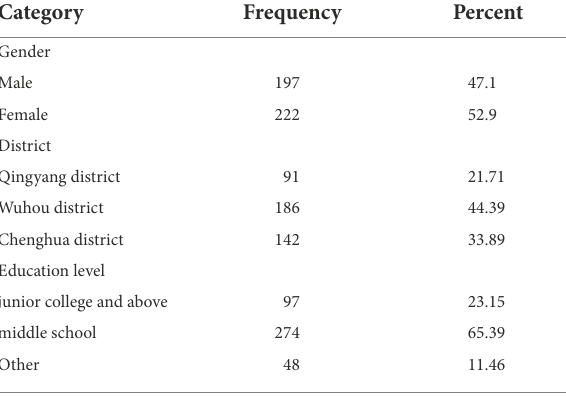
TABLE 1 Subjects’ basic information characteristics ( N =